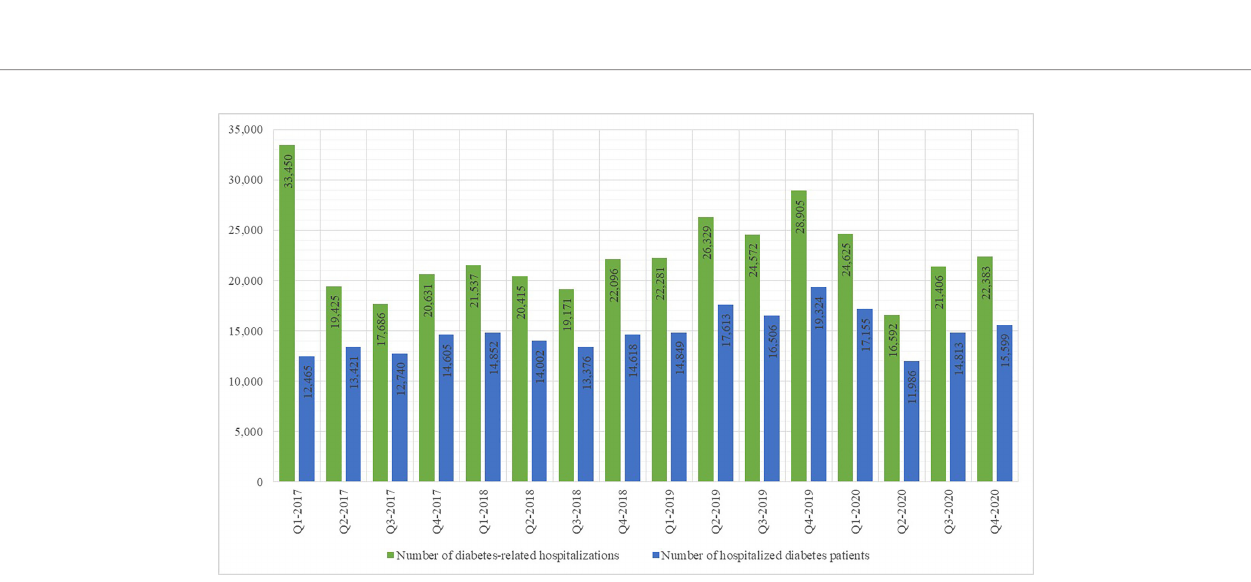
FIGURE 2 | Number of diabetes-related primary healthcare visits per yearly quarter 2017 -